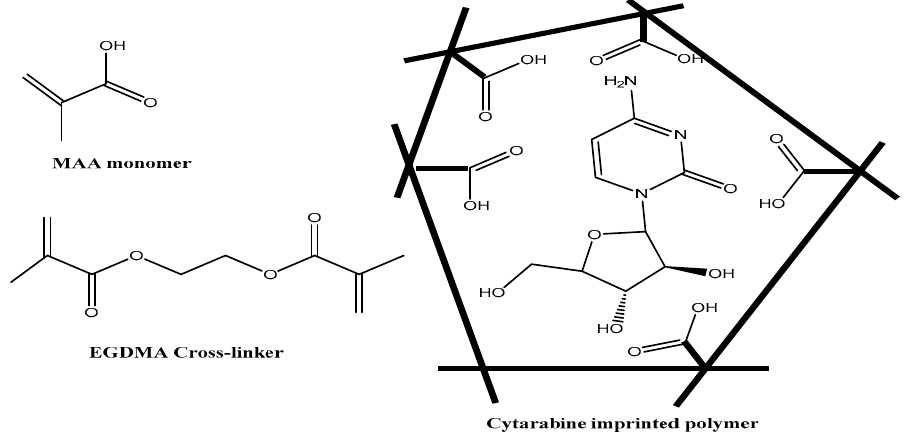
Figure 1. Schematic representation of the cytarabine imprinting process.